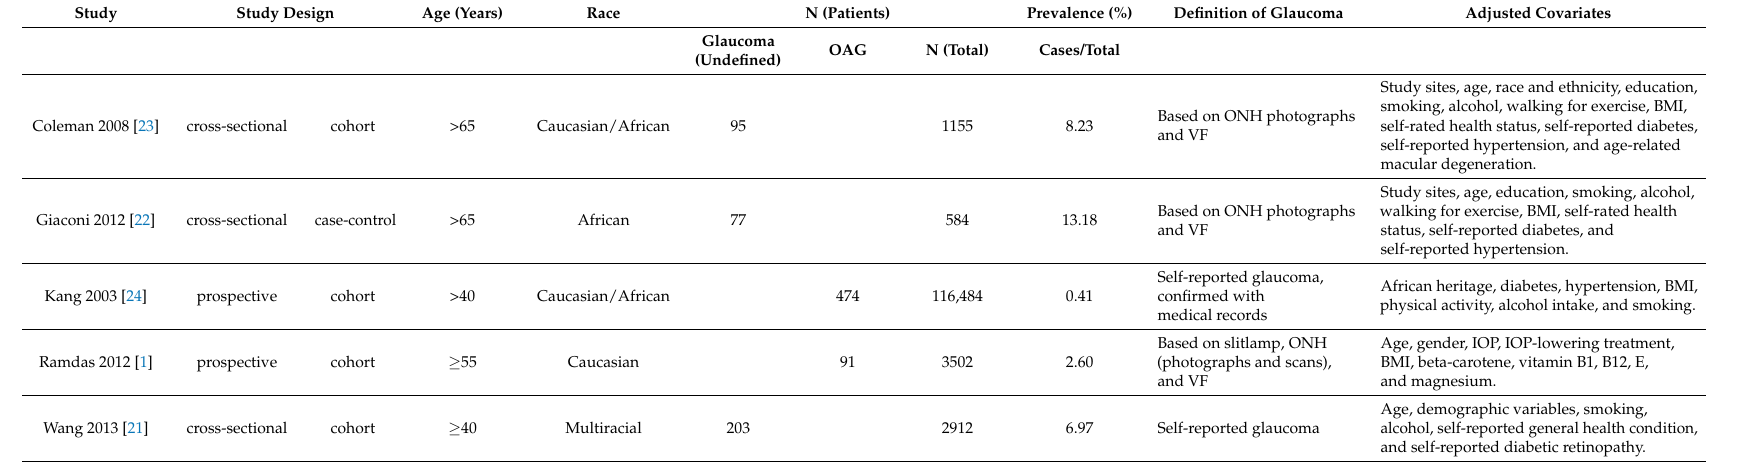
Table 2. Characteristics of the included studies for the